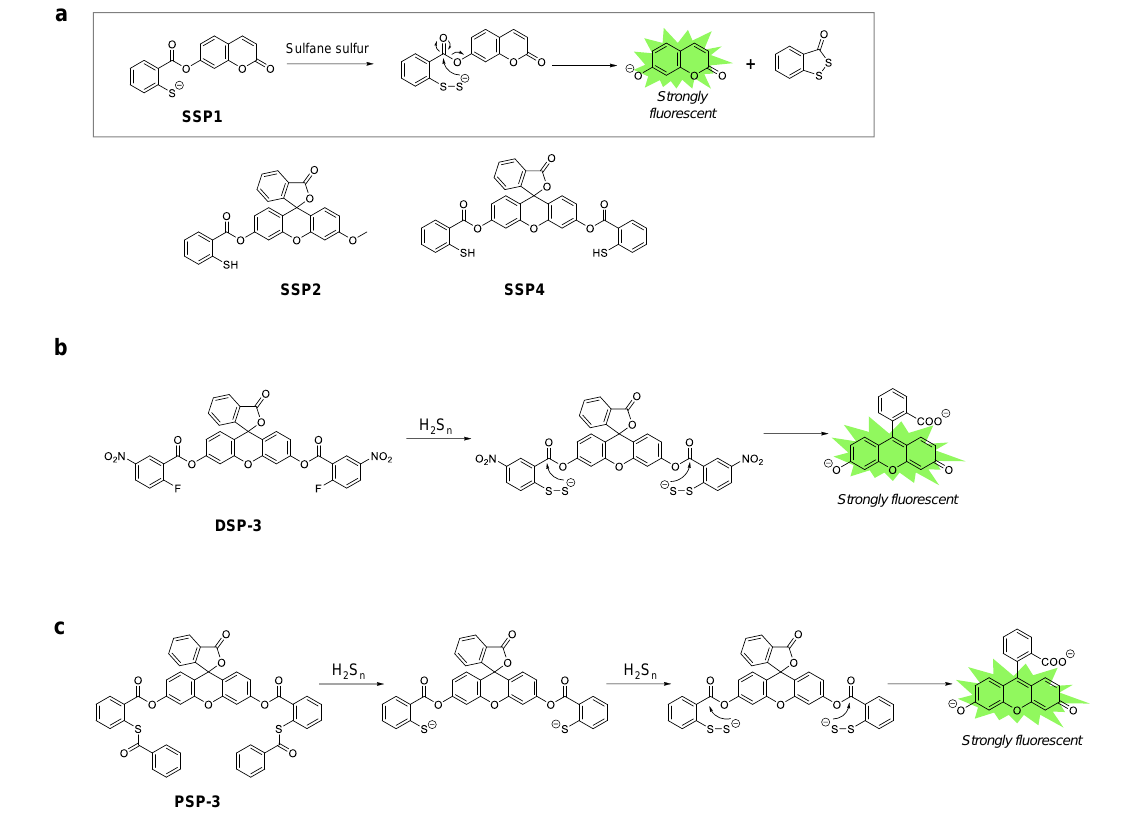
Figure 3. ( a ) Chemical structures of the SSP series and the proposed reaction mechanism with sulfane sulfur. ( b ) Chemical structure of DSP-3 and its reaction mechanism with hydrogen polysulfides. ( c ) Chemical structure of PSP-3 and its reaction mechanism with hydrogen polysulfides.